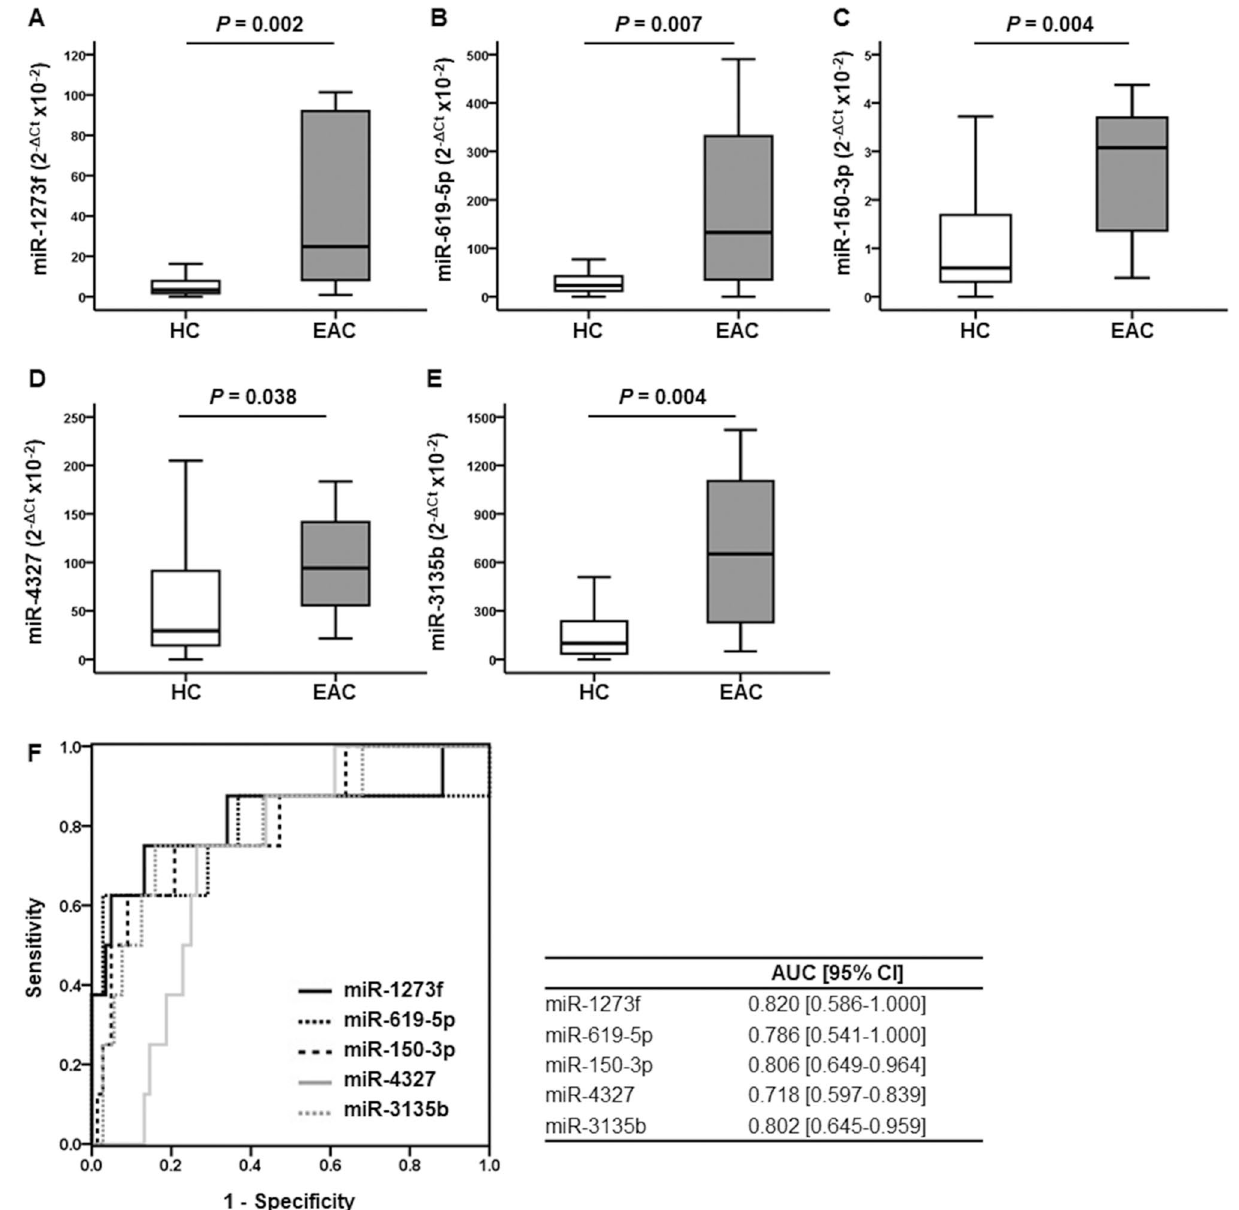
Figure 4. Urinary expression levels of miRNAs in the esophageal adenocarcinoma cohort. ( A ) miR-1273f., ( B ) miR-619-5p, ( C ) miR-150-3p, ( D ) miR-4327, ( E ) miR-3135b. Data were analyzed by Mann–Whitney U test. ( F ) Receiver operating characteristic curves. Receiver operating characteristic curves were obtained from urinary miRNAs (HC vs. EAC). EAC esophageal adenocarcinoma; AUC area under the curve; 95% CI 95% confidence